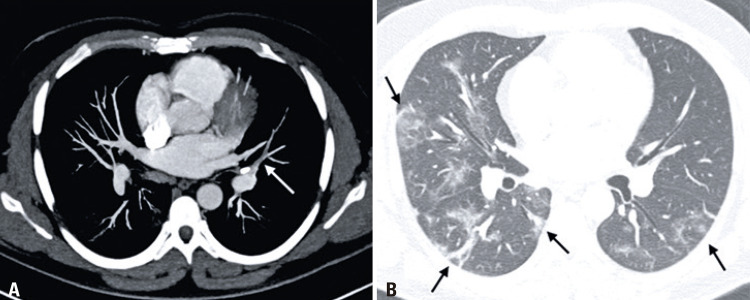
Angiotomografia computadorzada de tórax (paciente de 41 anos). (A) Corte axial em janela de mediastino evidenciando tromboembolismo pulmonar em ramo arterial segmentar lingular (seta branca). (B) Corte axial em janela para avaliação do parênquima pulmonar revela múltiplas opacidades em vidro fosco com espessamento de septos interlobulares, por vezes associadas a bandas parenquimatosas, achados bilaterais e predominantemente periféricos, consistentes com pneumonia por coronavírus